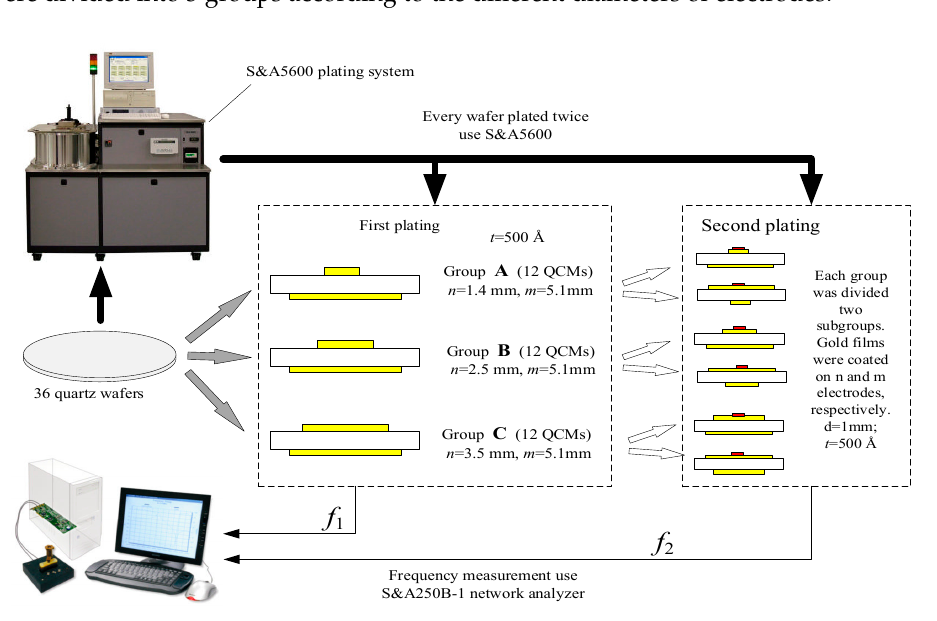
Figure 2. Schematic diagram of the experimental setup.